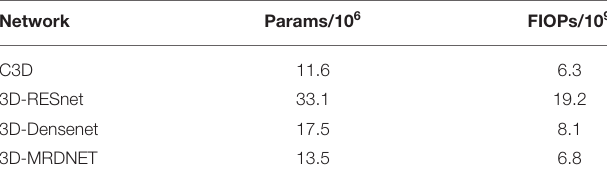
TABLE 2 | Params and FIOPs in different